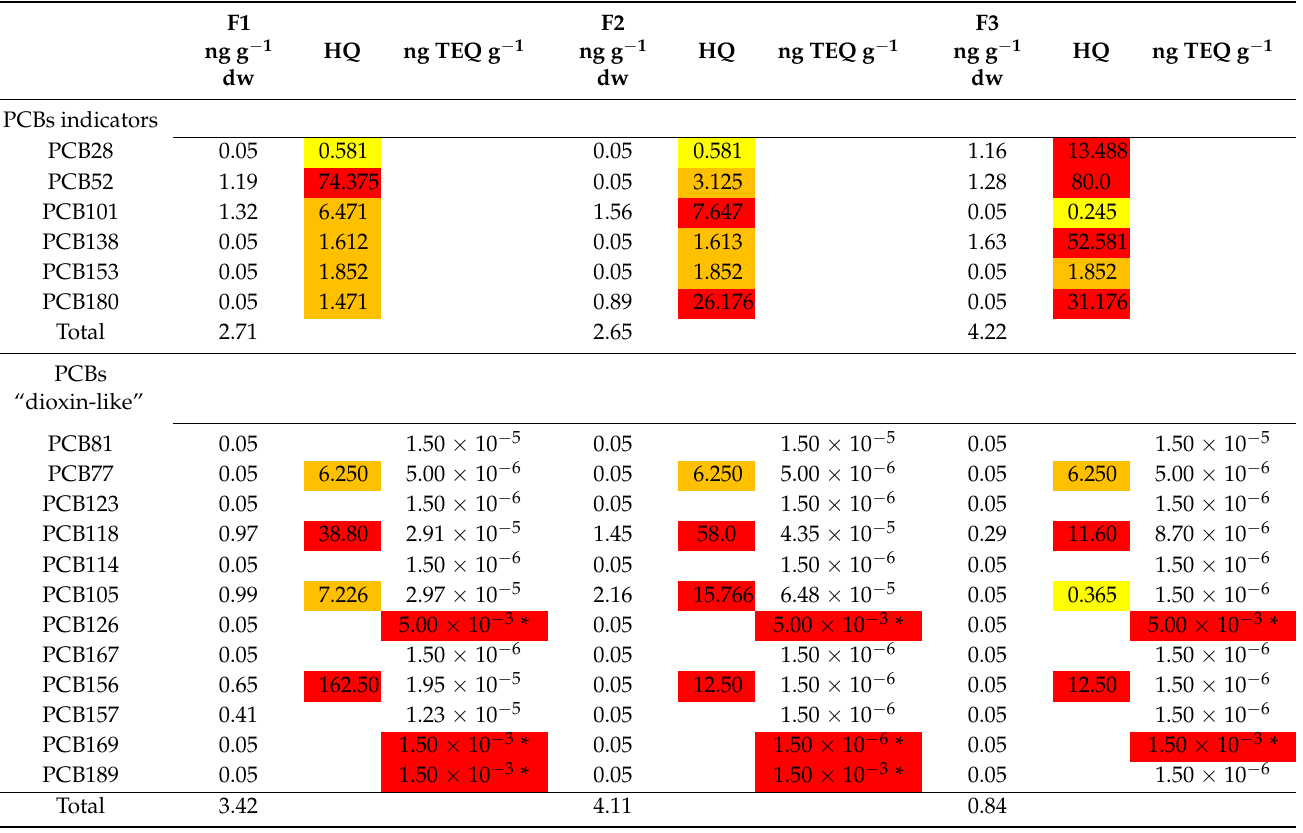
Table 5. Measured mean environmental concentrations (MEC) and Hazard Quotient (HQ) and TEQ (toxic equivalents) for the analyzed PCBs in sediments in F1, F2, and